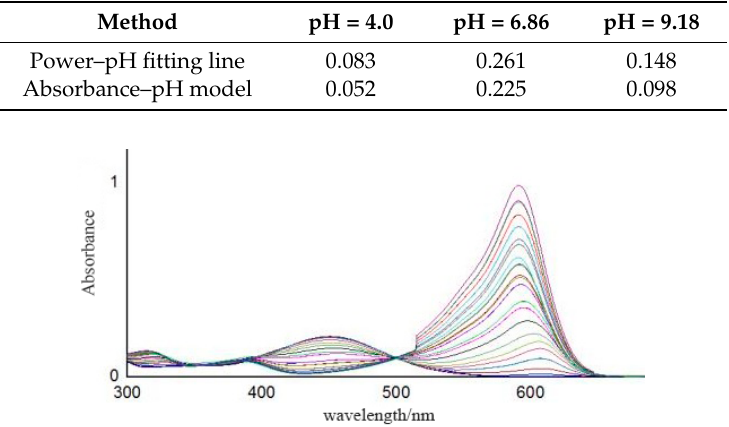
Table 6. Acid dissociation constant (p K a ) of the four